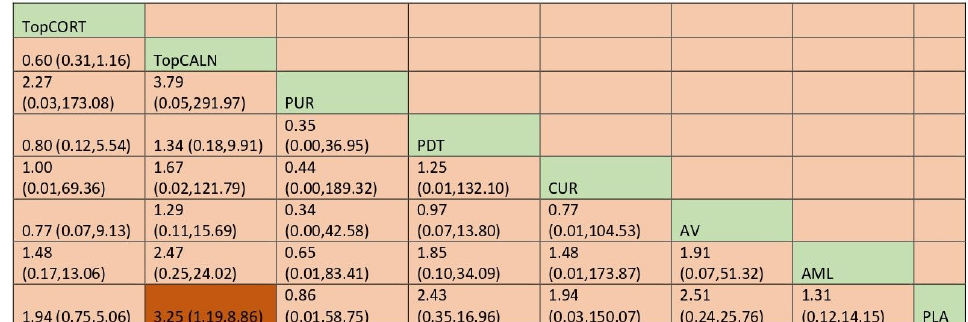
Figure 5. Network plot: Clinical Improvement of Oral Lichen Planus. Abbreviations: AML, amlex ‐ anox paste; AV, aloe vera; CUR, curcumin gel; PDT, photodynamic therapy; PLA, placebo; PUR, purslane; SysCORT, systemic corticosteroid; TopCALN, topical calcineurin; TopCALNcoSysCORT, topical calcineurin combined with systemic corticosteroid; TopCORT, topical corticosteroid.